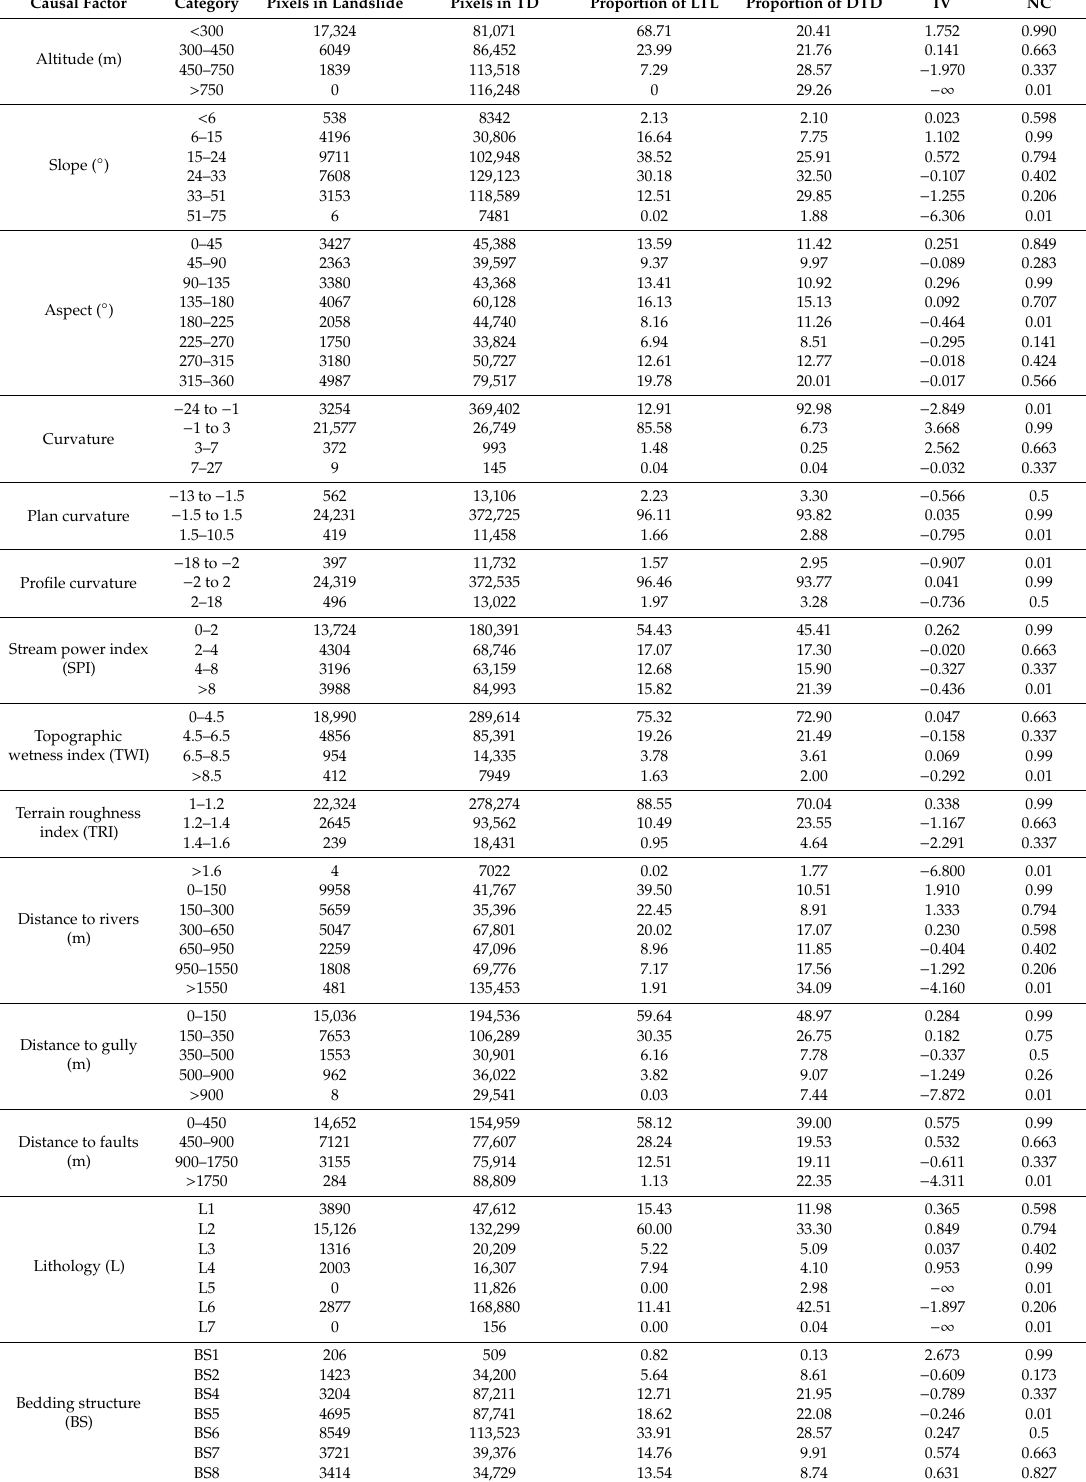
Table 1. Spatial relationships between causal factors and